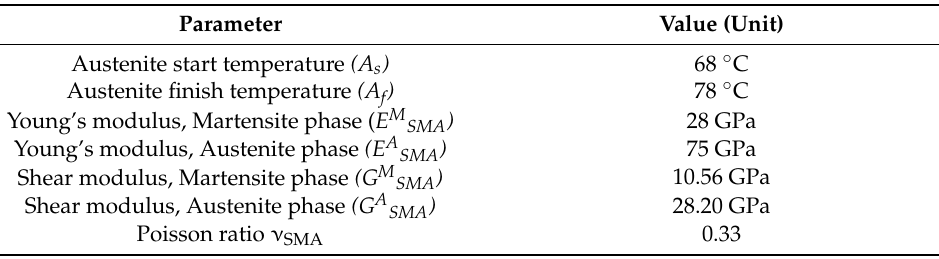
Table 2. SMA properties in martensite and austenite